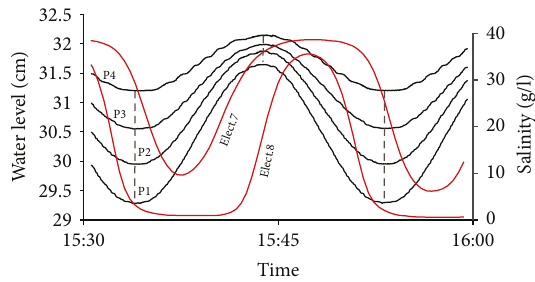
Figure 5: Water levels at all four piezometers and salinities at two electrodes which are located at the same depth (#7 and #8). Locations of the electrodes are shown in Figure 1(b). Note that the salinity peaks appear ~ 2 minutes after the water level peaks.